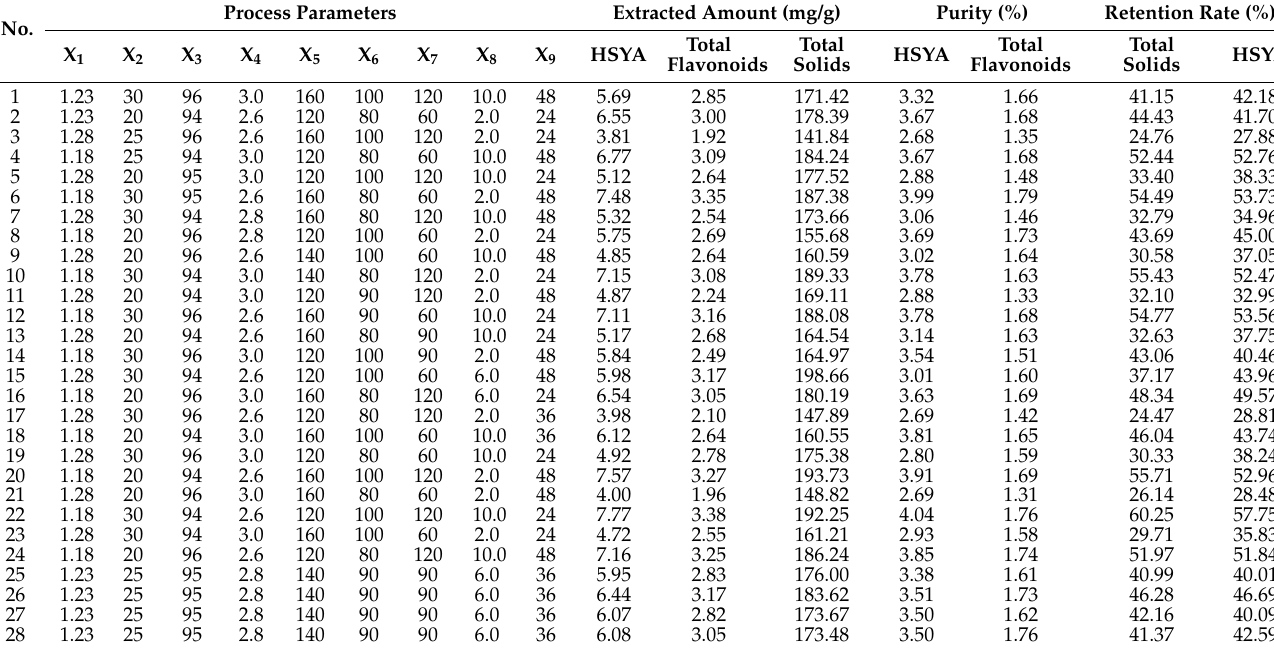
Figure A1. Typical HPLC chromatogram of the reference standard and the Carthami Flos sample. ( a ) HPLC chromatogram of the HSYA. ( b ) HPLC chromatogram of the ethanol precipitation super- natant. ( c ) HPLC chromatogram of the concentrated extract. Table A1. The results of the definitive screening